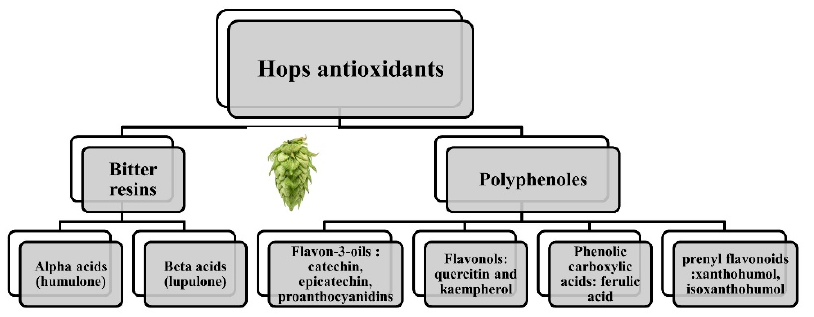
Figure 1. Antioxidants in hops.